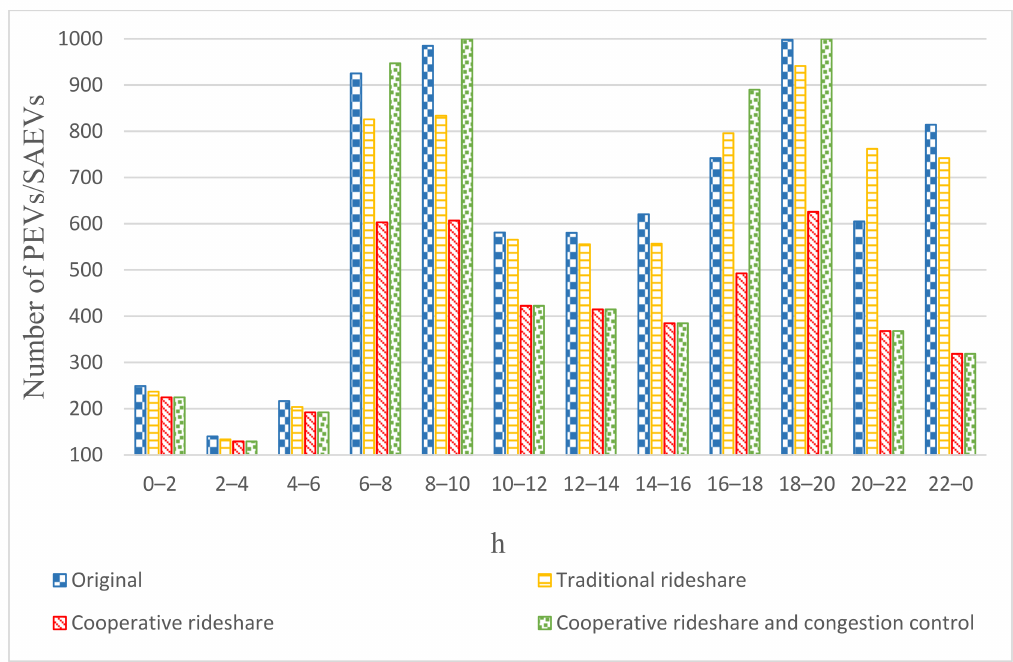
Figure 11. Traffic volumes of PEV/SAEV passengers on minor arterial